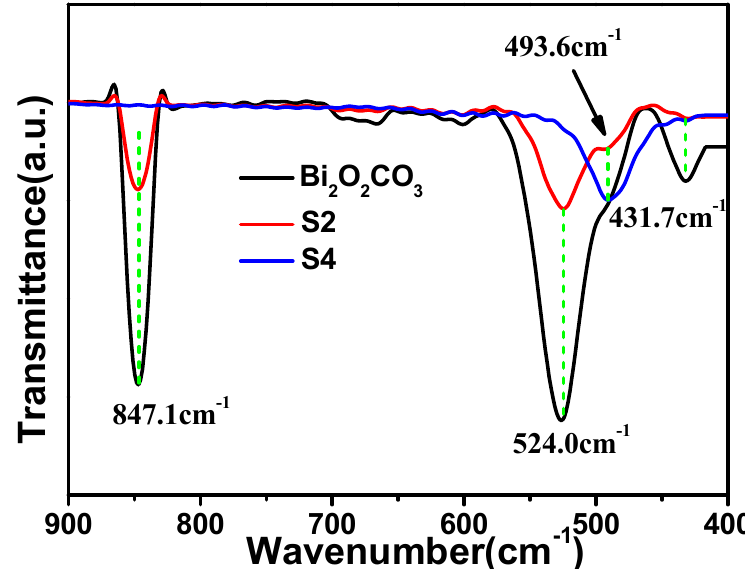
Figure 4. FT- IR spectra of Bi 2 O 2 CO 3 , S2 and S4 (pure BiOI) samples. UV-vis diffuse reflectance spectroscopies (DRS) of Bi 2 O 2 CO 3 , S2 and S4 were per- formed to study their optical absorption properties. The absorption band edge of Bi 2 O 2 CO 3 and BiOI are ~450 and 670 nm (Figure 5a), respectively, indicating the wider band gap of Bi 2 O 2 CO 3 than that of BiOI. The absorption band edge of the S2 heterostructure red-shifts compared with Bi 2 O 2 CO 3 due to the loaded-BiOI with narrower band gap (Figure 5b). The optical band gap of Bi 2 O 2 CO 3 and BiOI is obtained using the following equation: α h ν = A(h ν − Eg) n/2 where α is the absorption coefficient, h is Planck’s constant, ν is the light frequency, A is the constant and Eg is the bandgap energy [49]. In our study, both Bi 2 O 2 CO 3 and BiOI possess indirect band gaps, so n = 4 [25,50]. The band gap energies are estimated to 2.96 eV for pure Bi 2 O 2 CO 3 , and 1.75 eV for pure BiOI (Figure 5b). 1.5 2.0 2.5 3.0 3.5 4.0 4.5 5.0 5.50.00.5 1.01.52.0 ( α h ν ) 2 / n